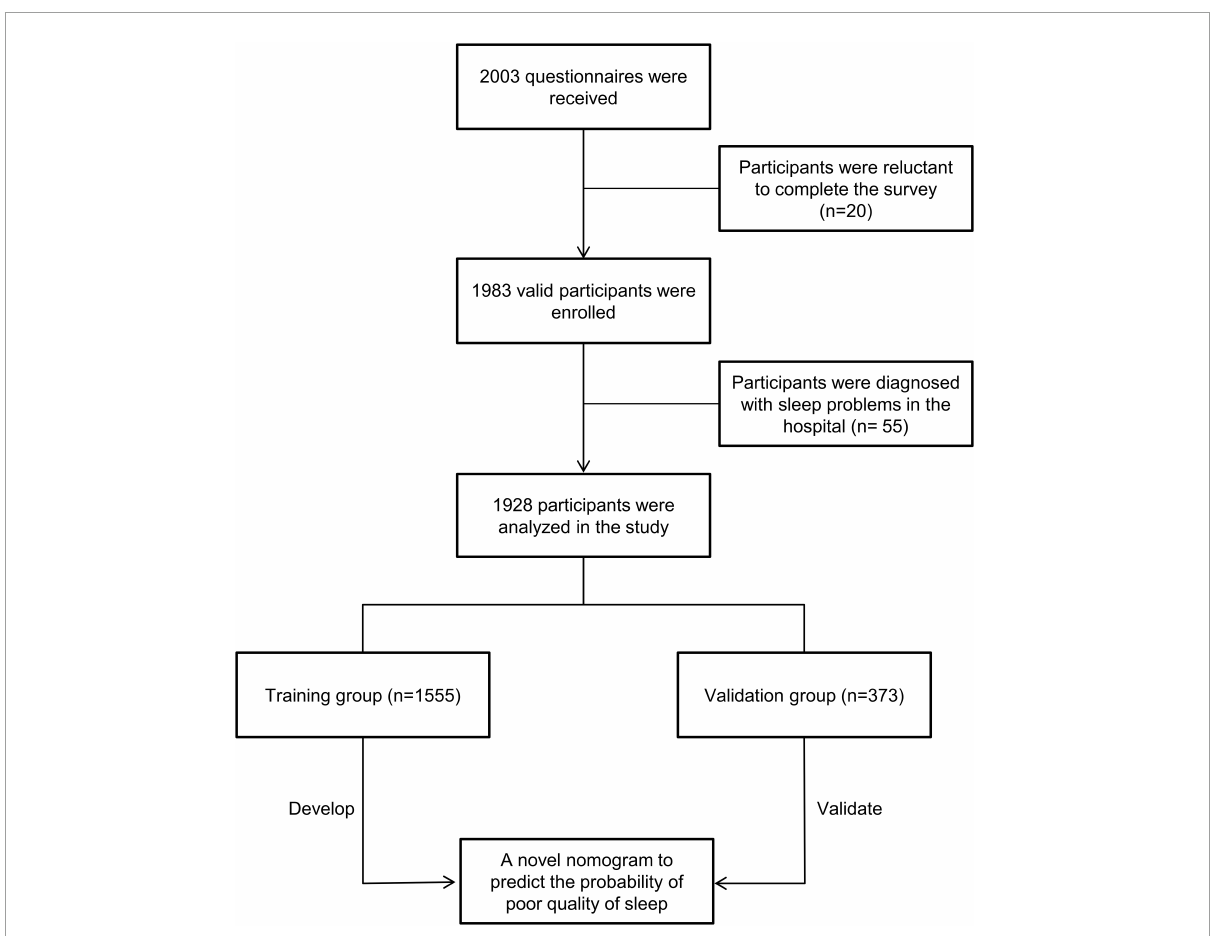
FIGURE1 Patient’s flowchart and study design. Based on inclusive and exclusive criteria, a total of 1,928 participants were enrolled and divided into a training group ( n = 1,555) and a validation ( n = 373) group.